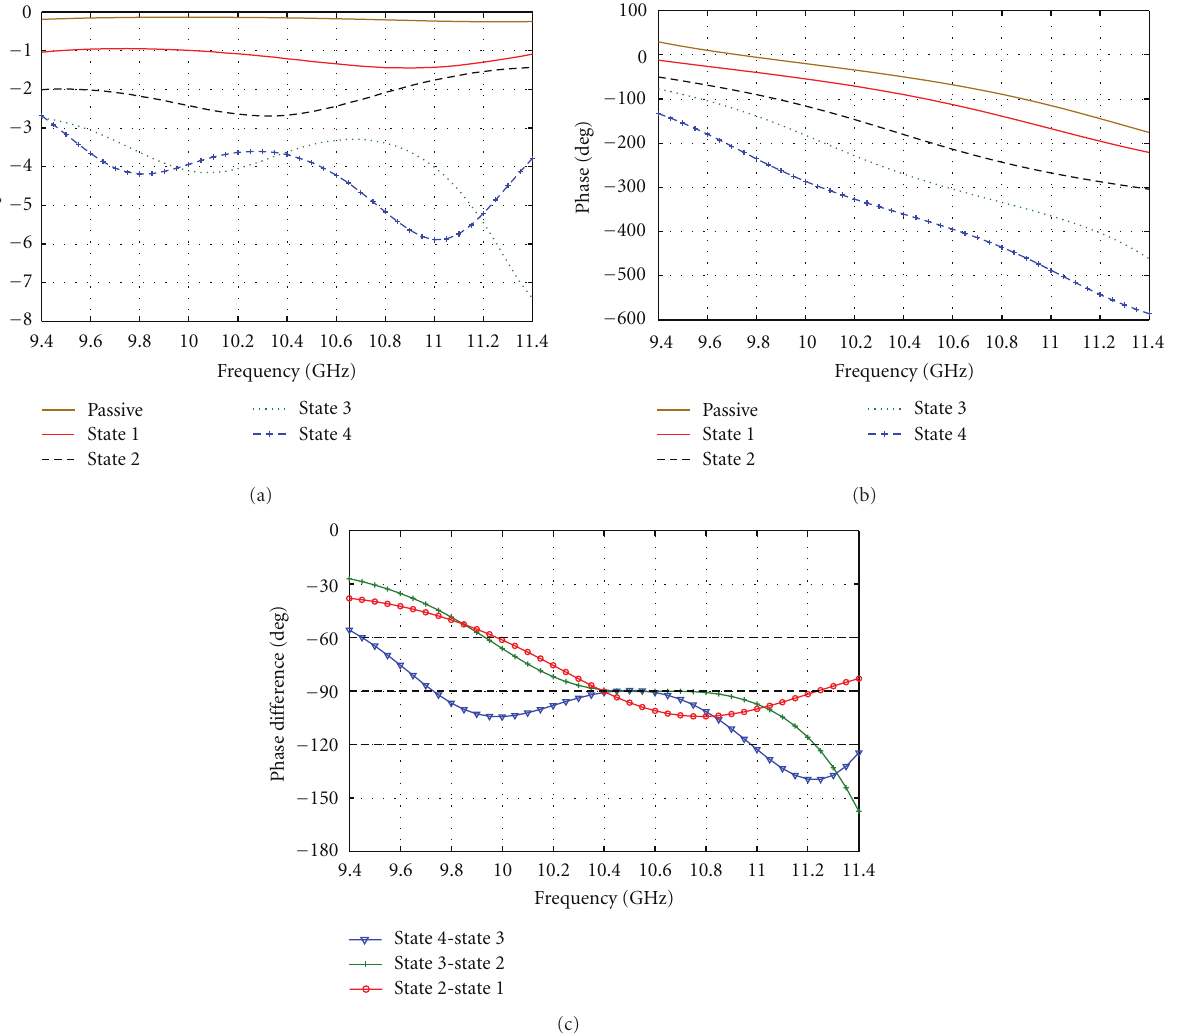
Figure 4: Reflection coe ffi cient versus frequency for a 2-bit reflectarray element in a periodic environment. (a) Amplitude. (b) Phase. (c) Phase di ff erence between the adjacent states.